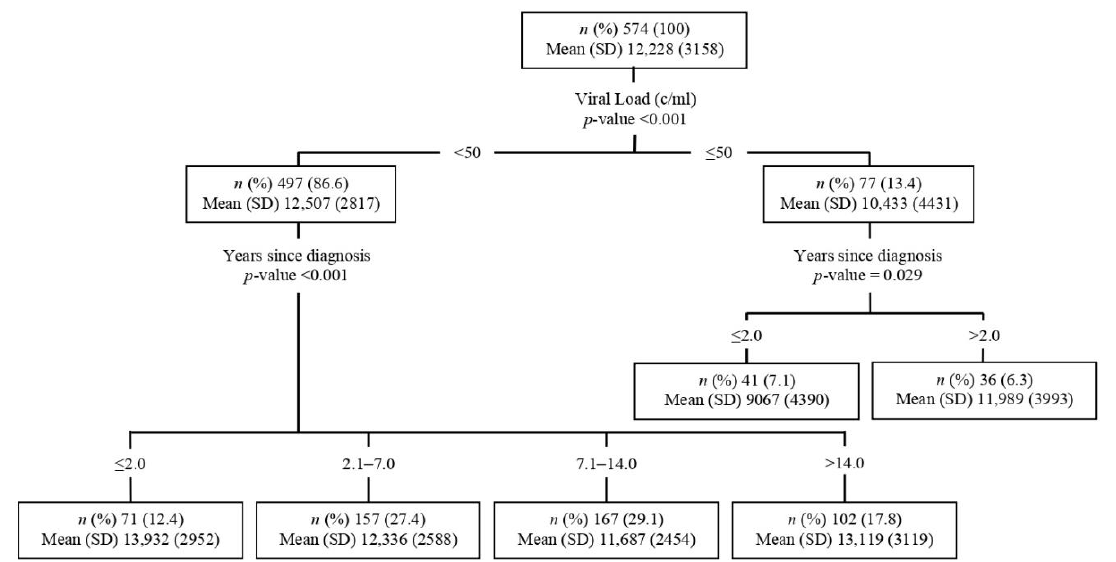
Figure 2. Chi-square automatic interaction detector (CHAID) analysis of factors associated with HIV-1-related direct costs. The CHAID algorithm builds a decision tree based on the full dataset by repeatedly partitioning each subset into at least two child nodes. This algorithm tries to explain the configuration of the association between potential explanatory variables and the outcome variable.